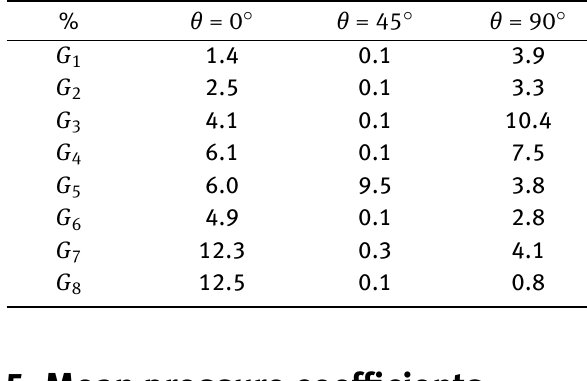
Table 3: Relative error in percentage between experimental values and by TSVD values